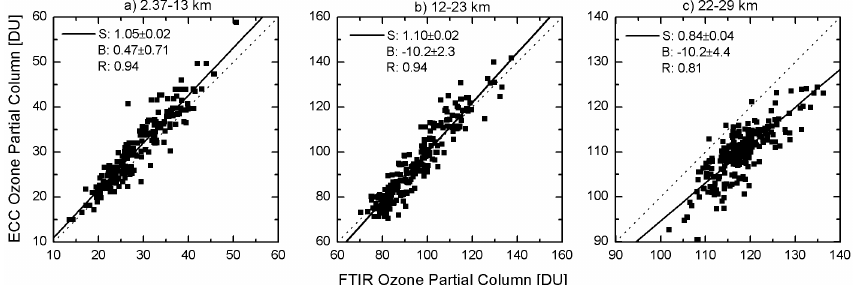
Fig. 10. Comparison between the ozone partial columns from FTIR (setup C) and ECC sonde data ( N = 262): (a) 2.37–13km, (b) 12–23km and (c) 22–29km. The black solid lines are the linear regression line of the least square fits, whose parameters are shown in the legend ( S and B are the slope and the bias of the regression fit, respectively, and R the correlation coefficient). The dotted lines are the diagonals.